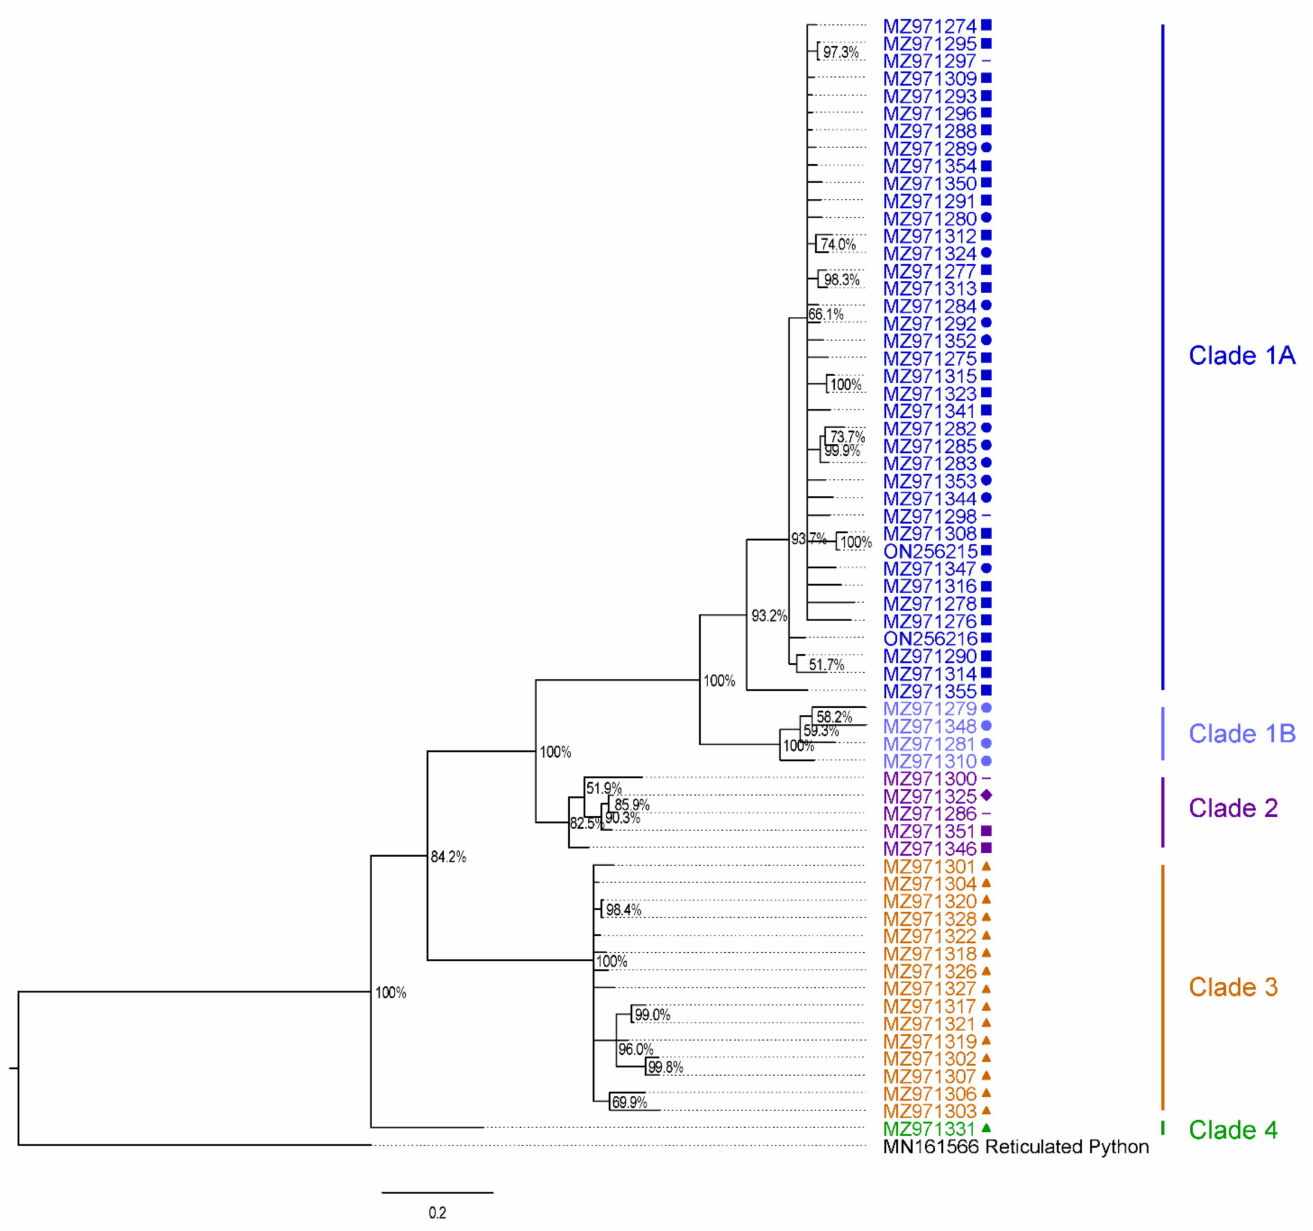
Figure 2. Bayesian phylogenetic tree of a 369-nucleotide fragment of the ORF1b gene from novel Burmese python serpentoviruses from southern Florida, USA. The Burmese python serpentoviruses formed 5 clades: clade 1A (navy blue), clade 1B (light blue), clade 2 (purple), clade 3 (orange), and clade 4 (green). Samples came from 4 subpopulations within the state of Florida, USA: western (trian- gle), northern (diamond), central (square), and southern (circle). A previously described reticulated python serpentovirus (MN161566) was used as an outgroup. Bayesian posterior probabilities are shown at branch points. The scale at the bottom represents expected substitutions per